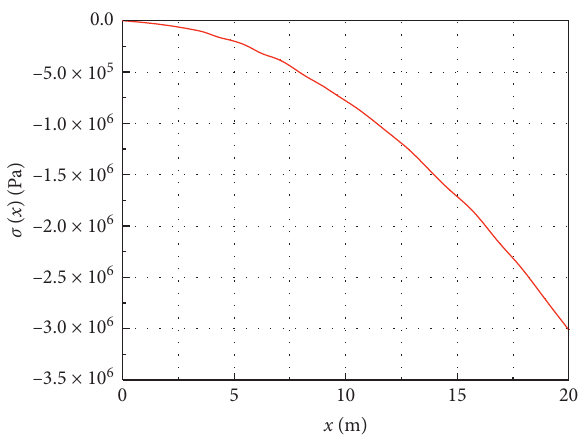
Figure 11: The variation of bending stress (III).